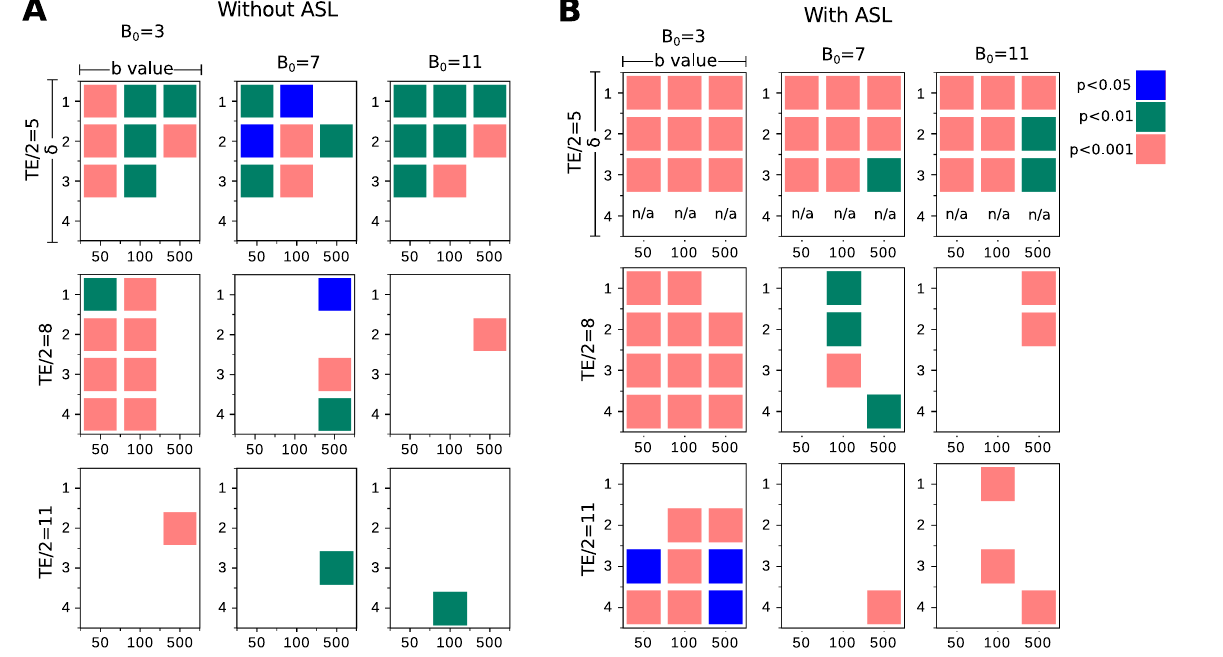
Figure 4. Using a subspace of parameters that determine our diffusion MRI sequence, we plot the corresponding statistical p values computed between our two synthetic groups based on their simulated signal- loss ( ψ ) values. ( A ) Without using ASL. ( B ) With